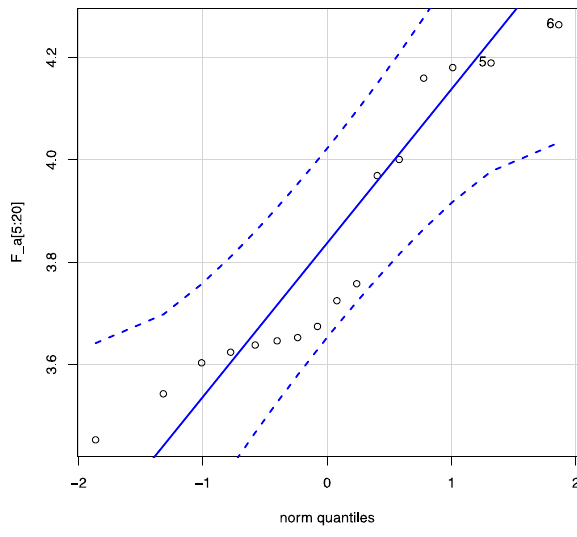
Figure 10. Normal Q–Q plot for Fa.